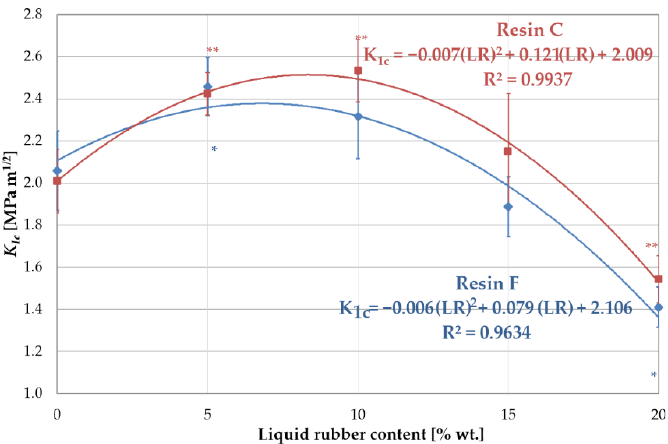
Figure 6. Fracture toughness K Ic of resin blends modified with liquid rubber. Symbols (*) and (**) indicates statistically significant differences in relation to the unmodified resin, for resin F and C, respectively.